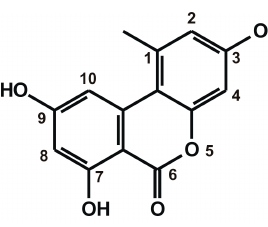
Figure 1. Chemical structure of alternariol.